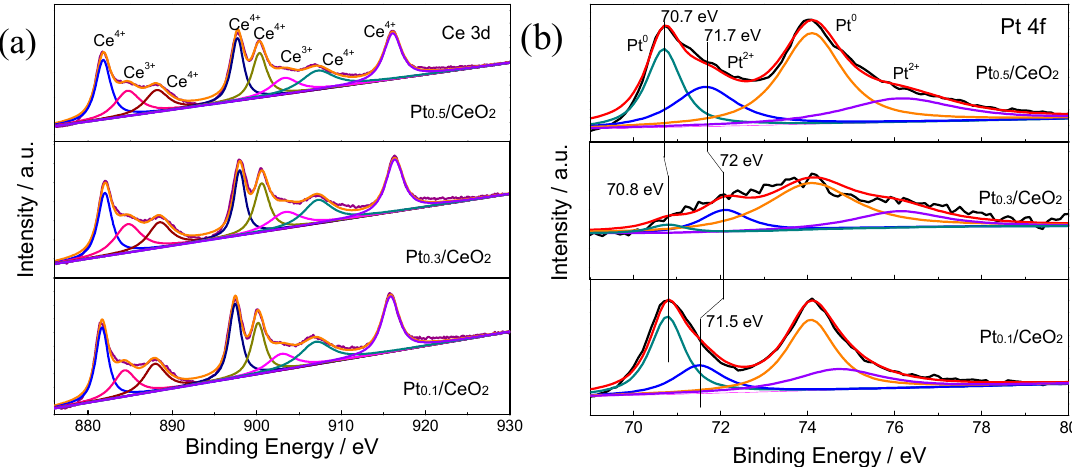
Figure 7. SEM image of the Pt 0.3 / CeO 2 catalyst after reaction for 130 h.